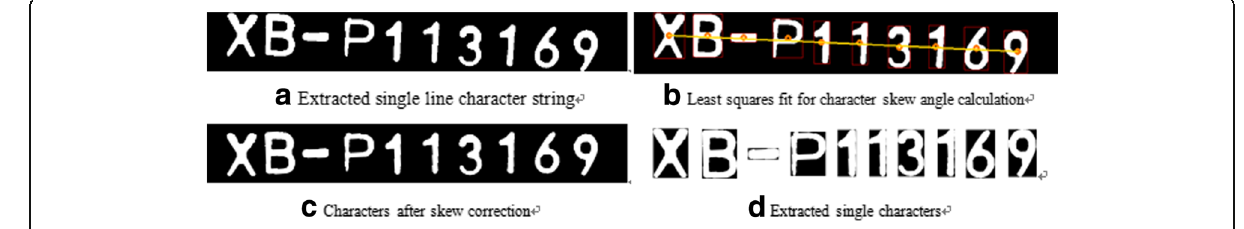
Fig. 6 a – d Processes and results for single character